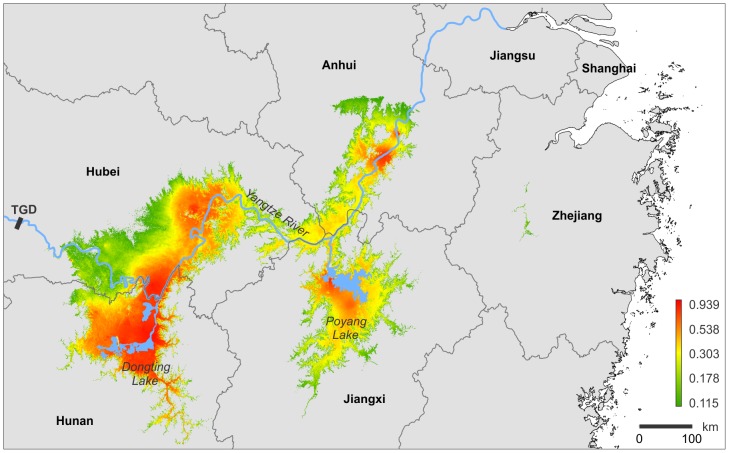
Output of the SESR modeling.Visualization of the schistosomiasis risk in eastern China (green color: low risk; red color: high risk). TGD = Three Gorges Dam.